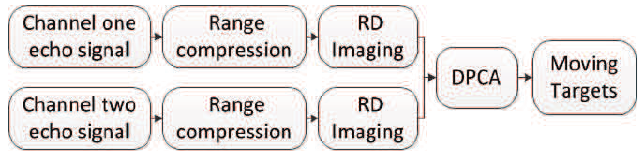
Figure 8. Flow chart of the RD based GMTI